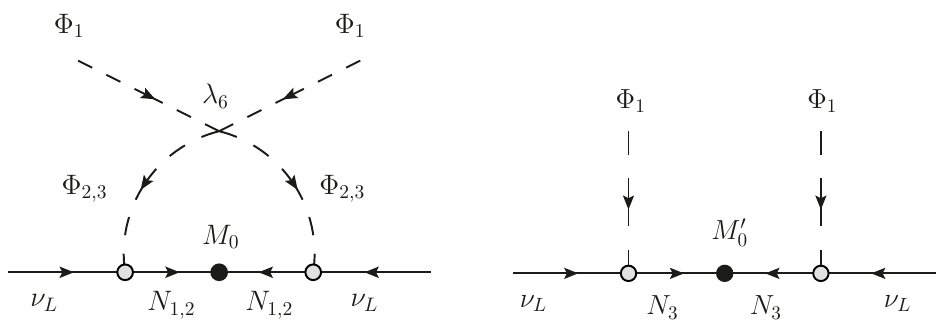
Figure 2 . In the CP4 symmetric model with three RH neutrinos, the (cid:12)rst two N 1 ; 2 generate the sco- togenic mass terms, while the third one N 3 produces a rank-1 mass term via the usual type 1